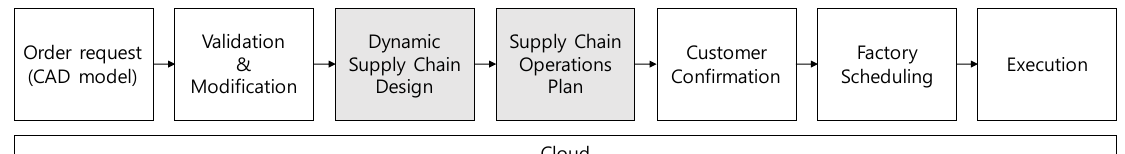
Figure 2. Smart supply chain planning process.